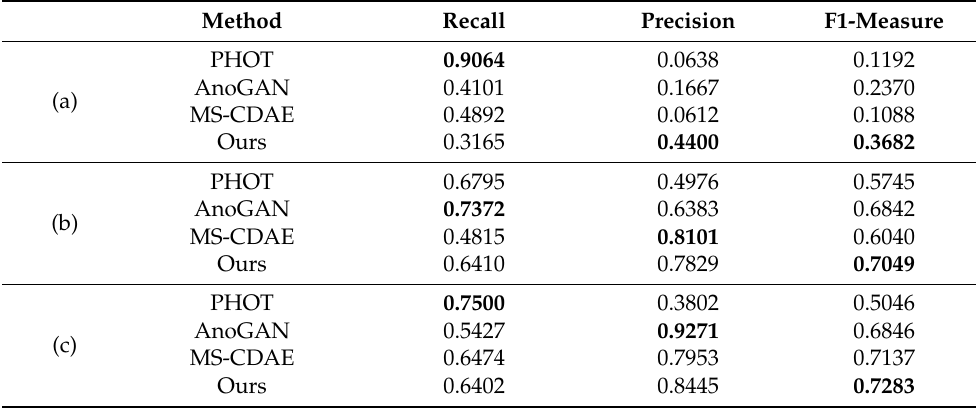
Table 6. Quantitative comparative results of Figure 9a–c between different